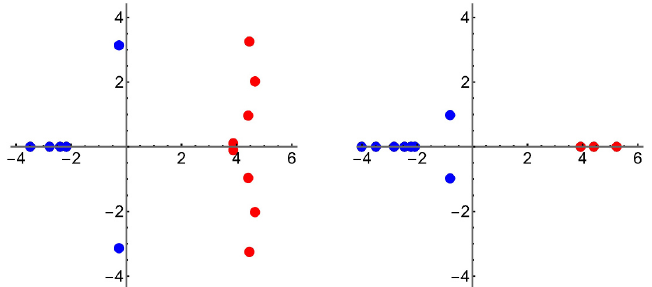
Figure 6. After subtracting the leading alternating and non-alternating contributions, we again perform a Borel-Padé computation for κ = − 0 . 75 (left) and κ = 0 . 4 (right). This seems to suggest that there is no longer a Borel singularity at ζ = 2 , but instead finding one at ζ = 4